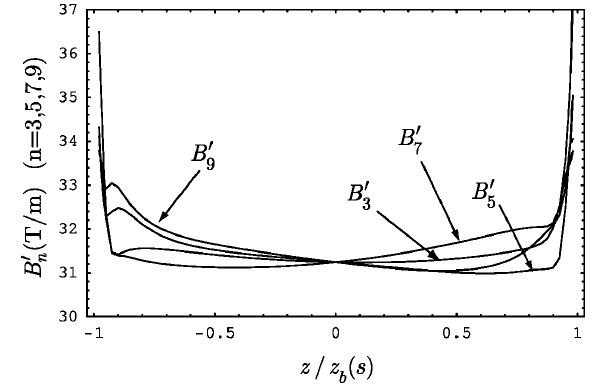
.FIG. 3. Envelope dynamics for the slice near the front end of (cid:3) s (cid:5) (cid:2) 0 : 96 the beam pulse with z=z b